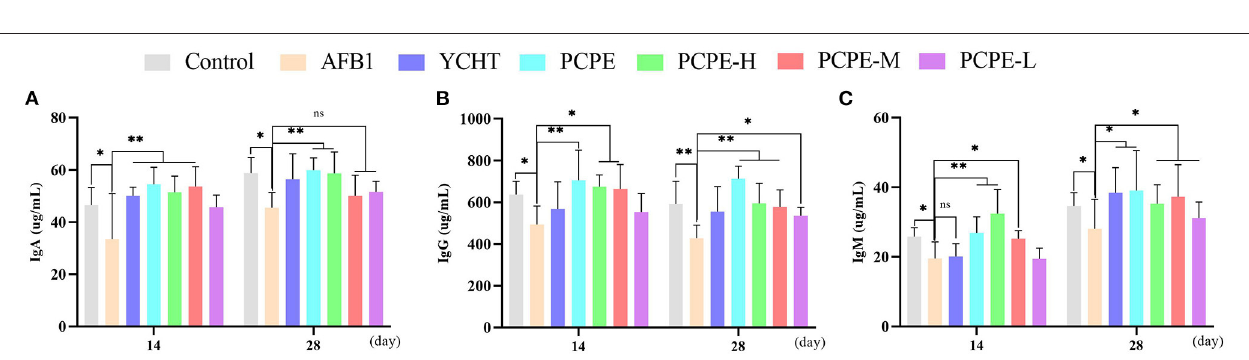
FIGURE 5 | Analysis of serum immunoglobulins on 14 th and 28 th day of experiment. Asterisk means significant difference ( p < 0.05) compared to the control and AFB1 group (* P < 0.05; ** P < 0.01, ns, non-significant). (A) IgA (B) IgG (C)